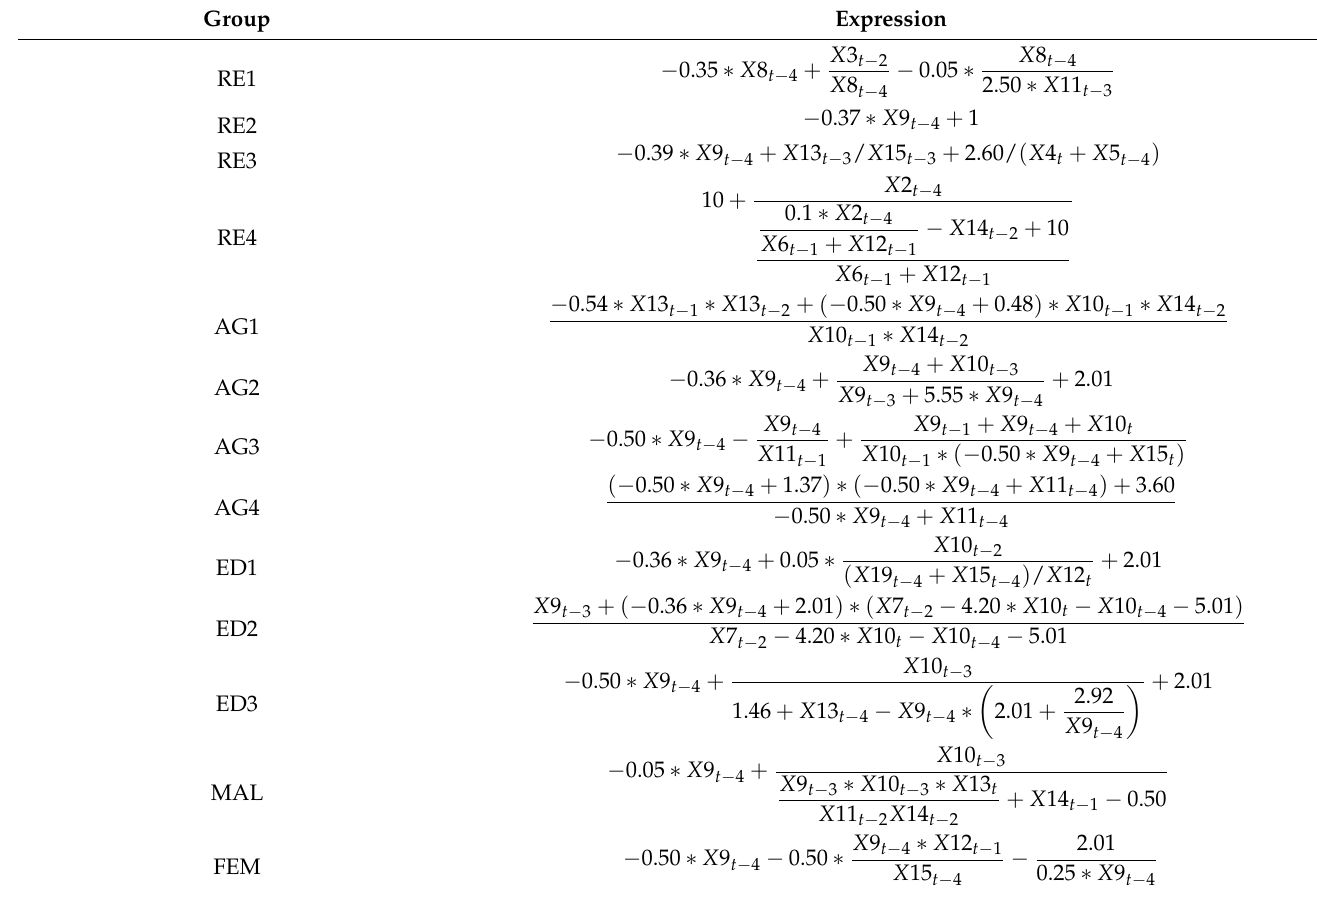
Table A1. Evolved indicators of unemployment for each sociodemographic group.